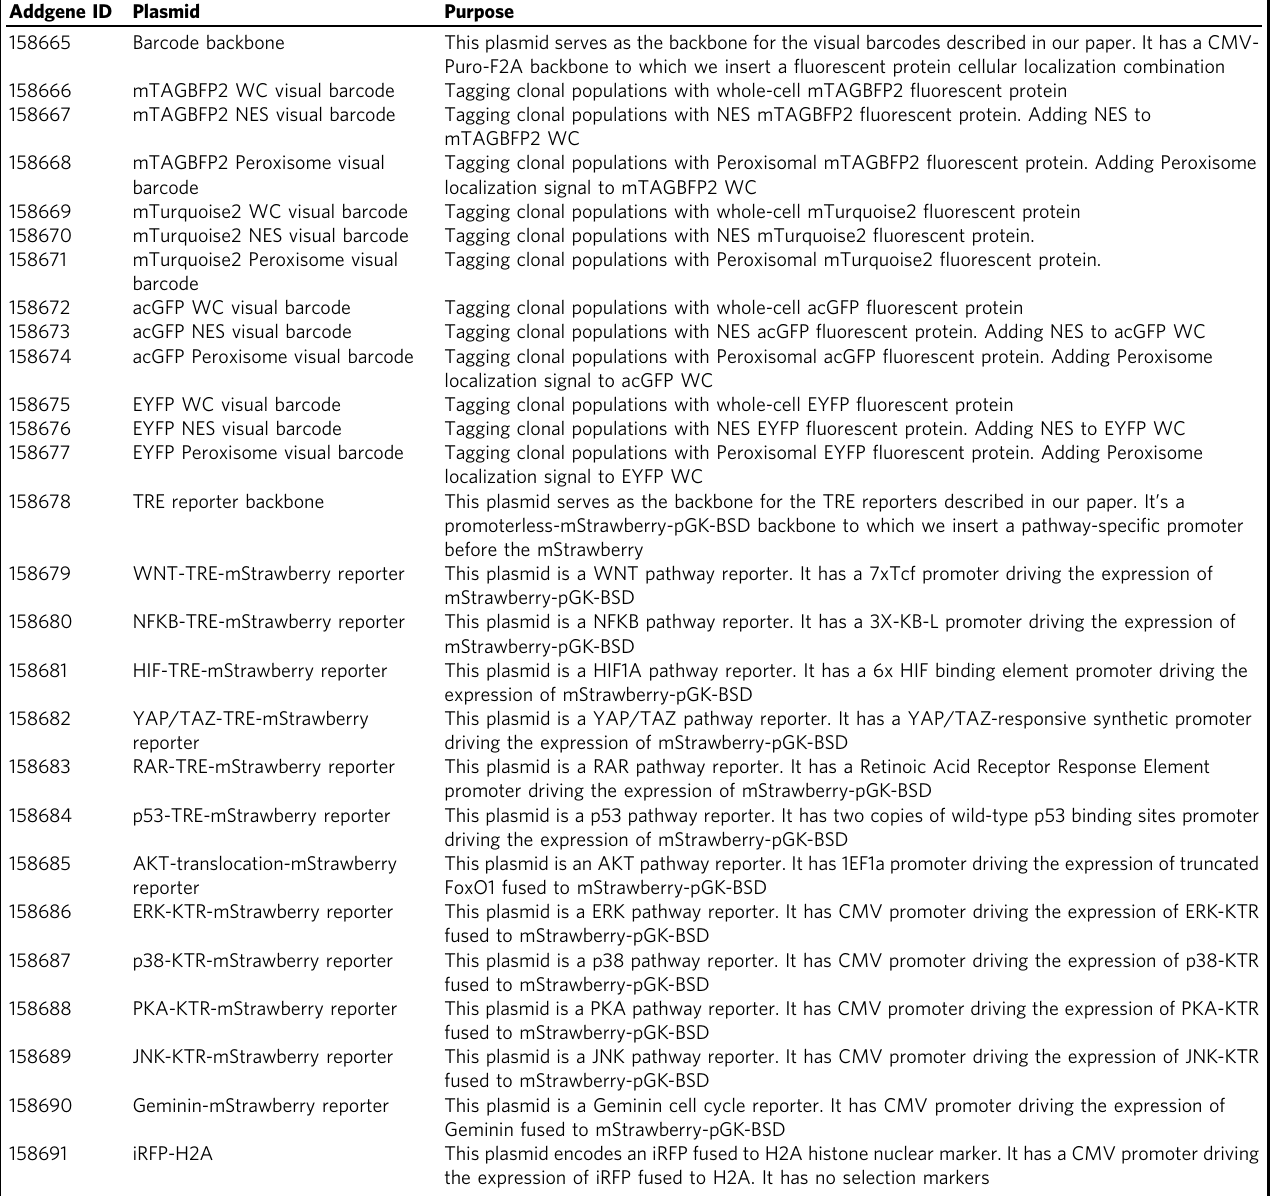
Table 1 Complete list of plasmids described in this paper to generate nuclear marker, visual barcodes, and live reporters. Addgene ID Plasmid